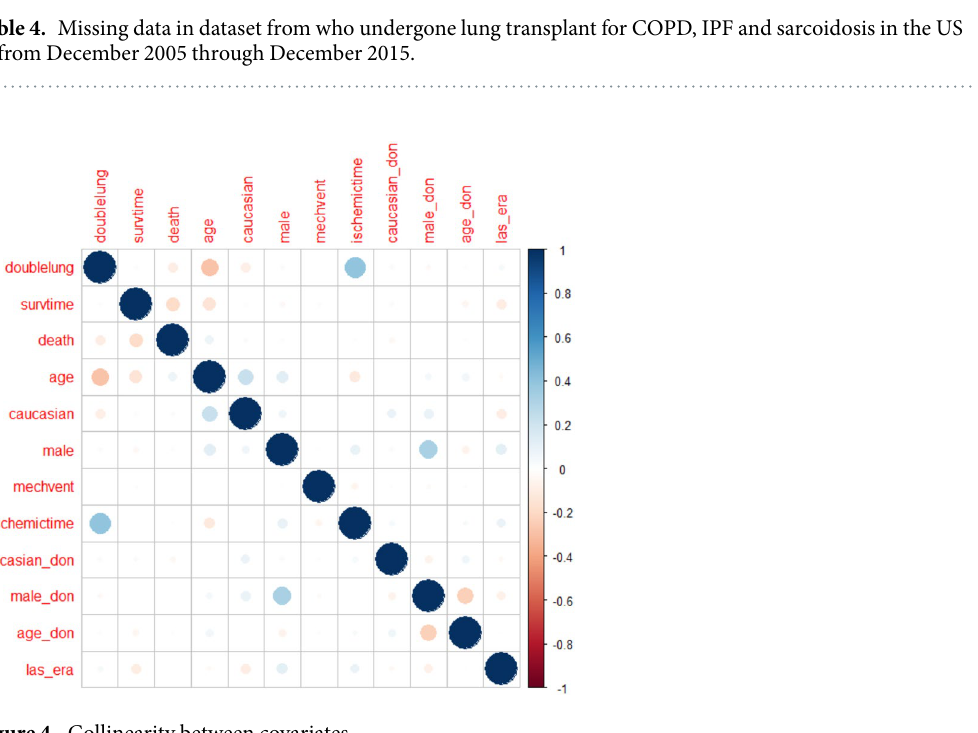
Figure 4. Collinearity between covariates.